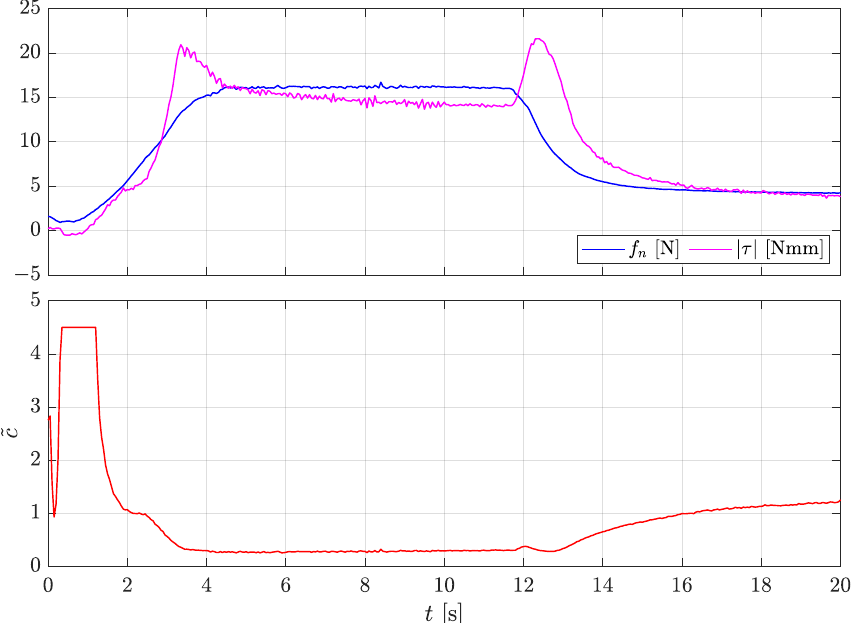
Figure 15. Third experiment: lifting the plastic bottle far from the CoG. Top plot: grasping force (blue), torsional torque (magenta). Bottom plot: estimated ˜ c .